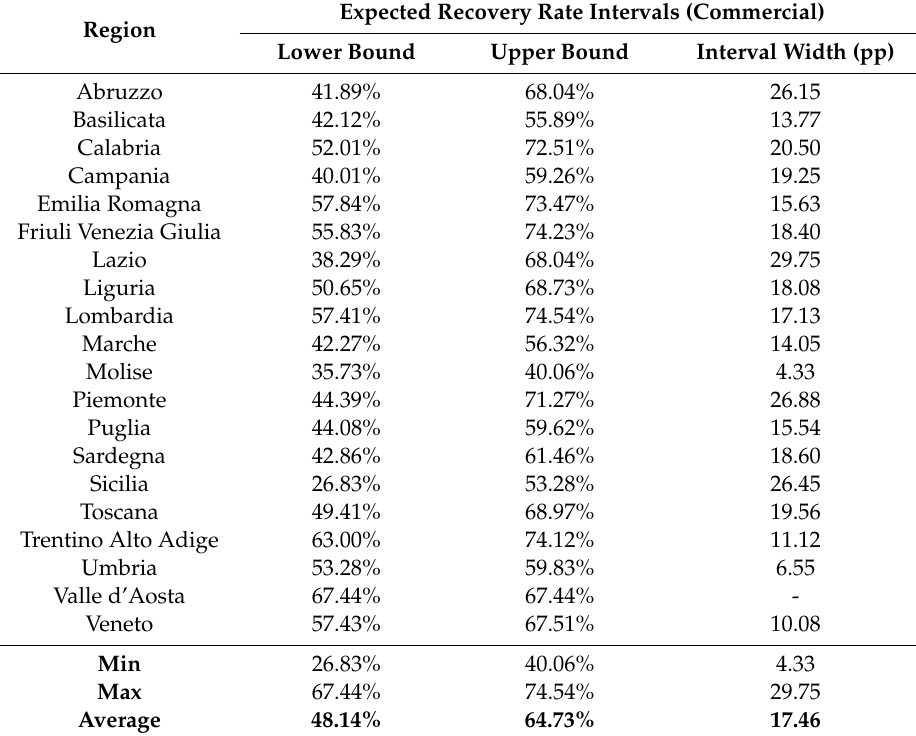
Table 3. Expected recovery ate intervals for commercial properties across